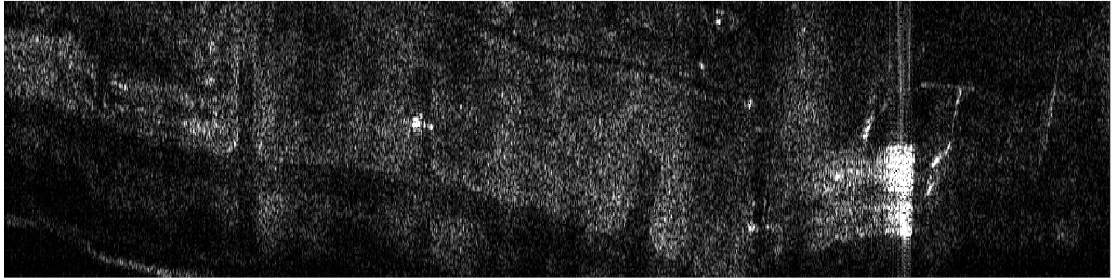
Figure 15. Radar terrain image obtained without MOCO.